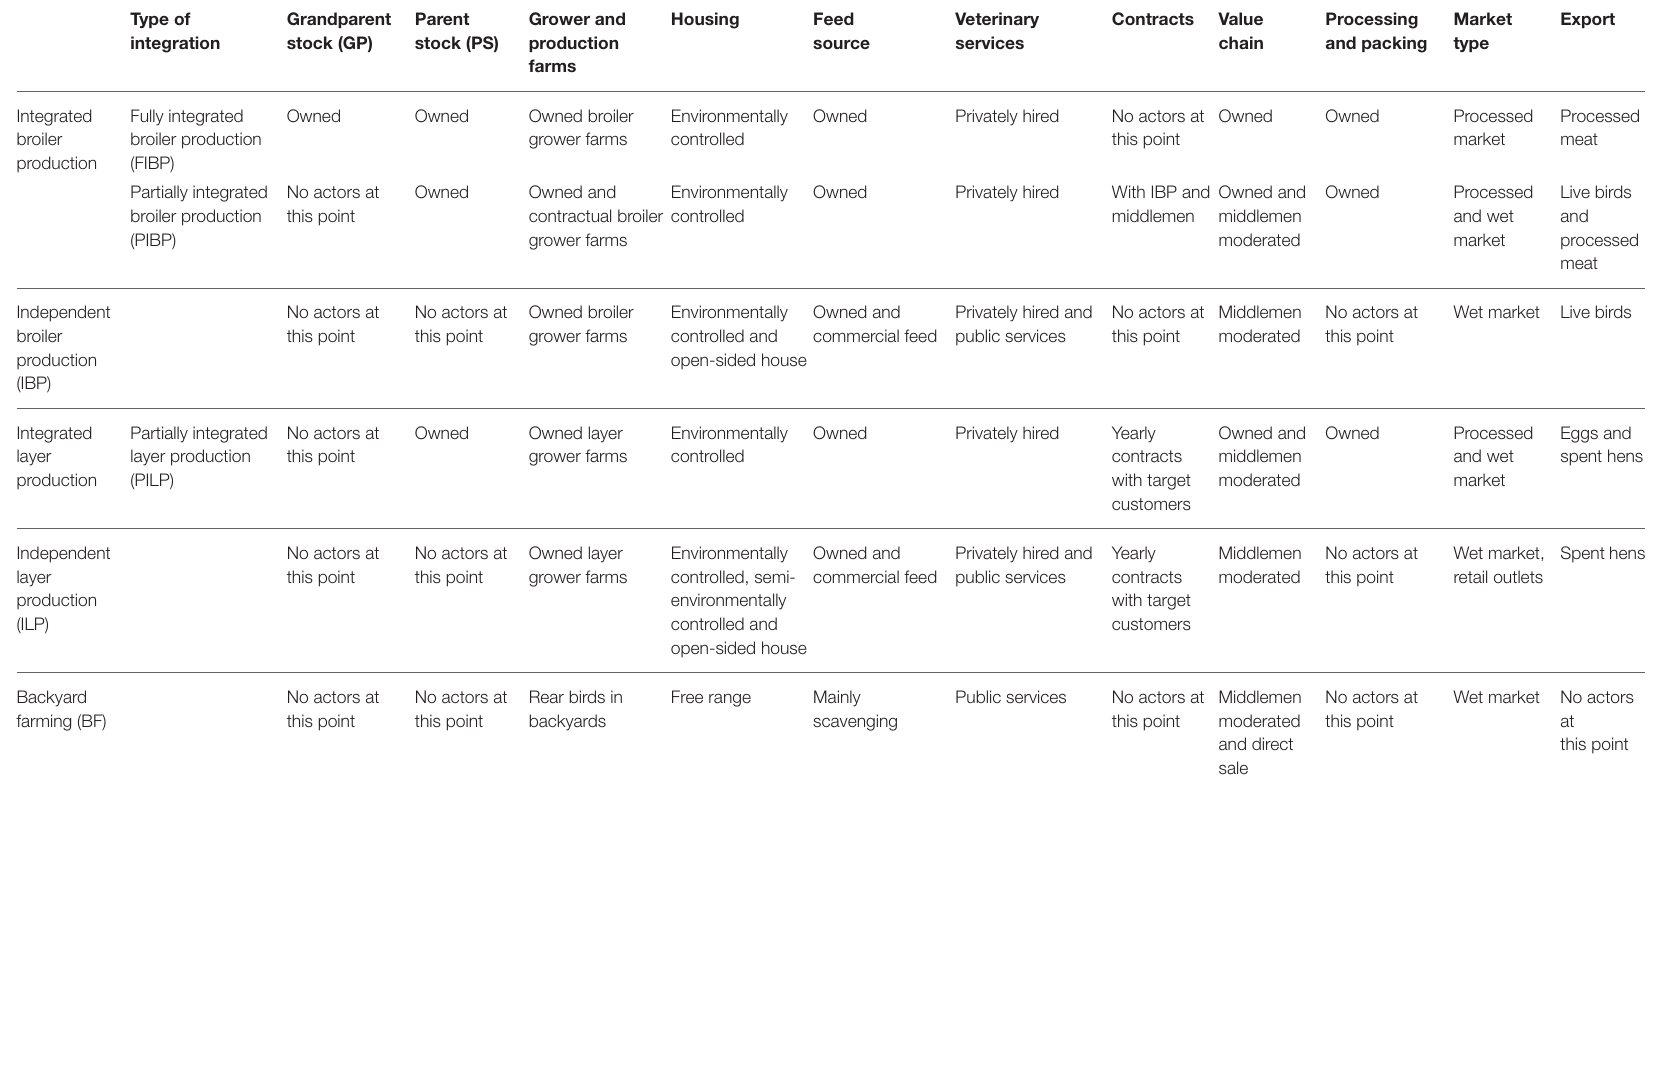
TABLE 2 | Main characteristics of broiler and layer production